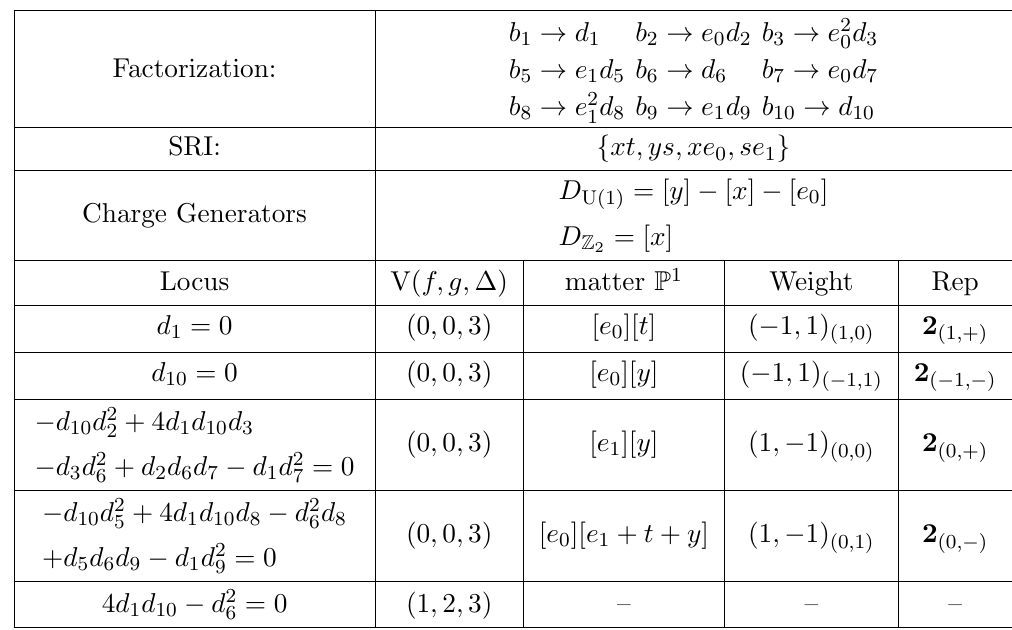
Table 12 . Summary of SU(2) top